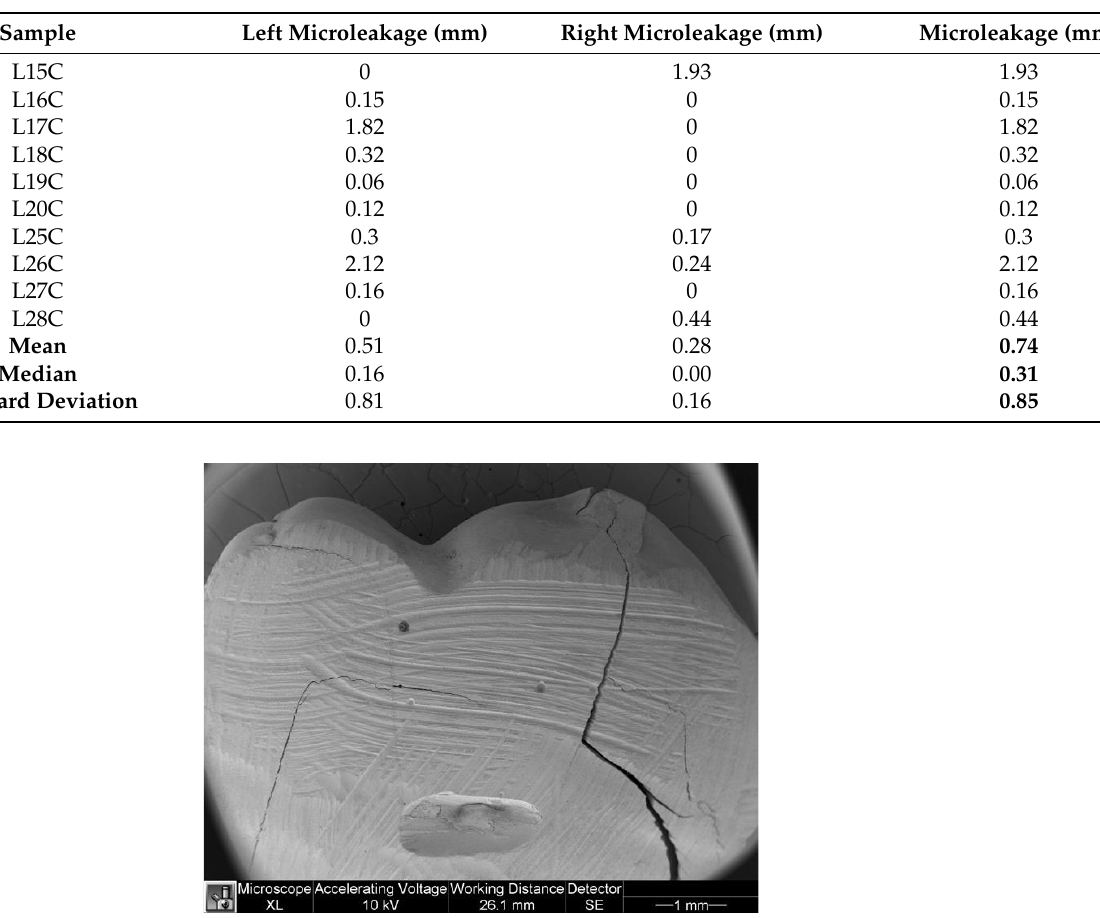
Table 2. Microleakage in the control group.